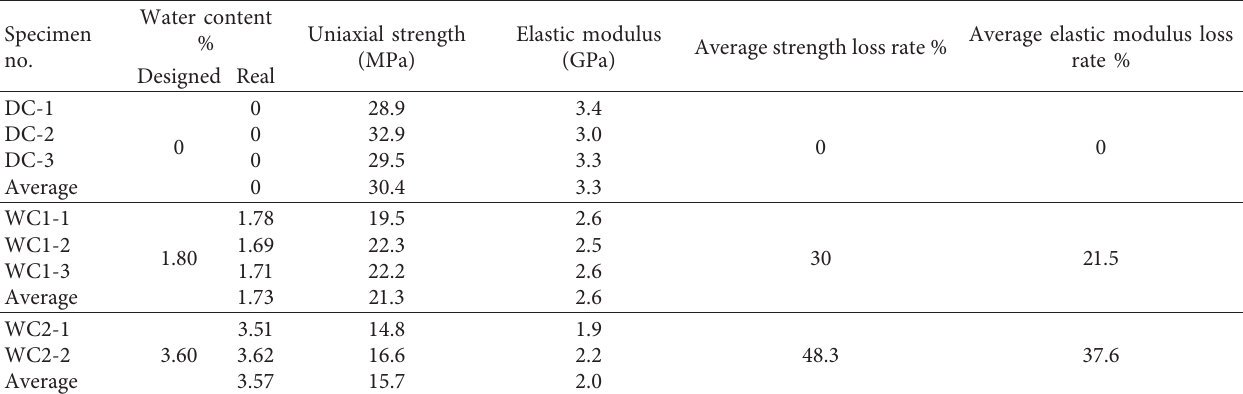
Figure 4: Stress-strain curves of the coal specimens under uniaxial compression: (a) DC group, (b) WC1 group, and (c) WC2 group. Table 2: Mechanical parameters of specimens under uniaxial